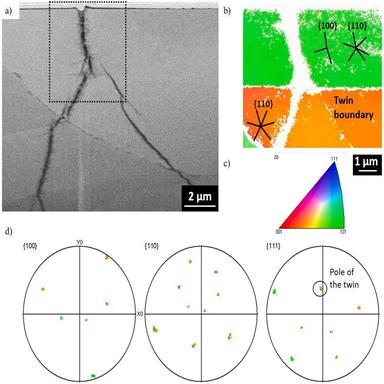
(a) ETD image of a FIB cross section of the crack. Note that the top of the image is the crack tip as observed in the metallographic cross-section sample. (b) IPF Z map and acquired in the region indicated by the rectangle in (a), and (c) corresponding IPF colour code. (d) Pole figures extracted from the region represented in (b).